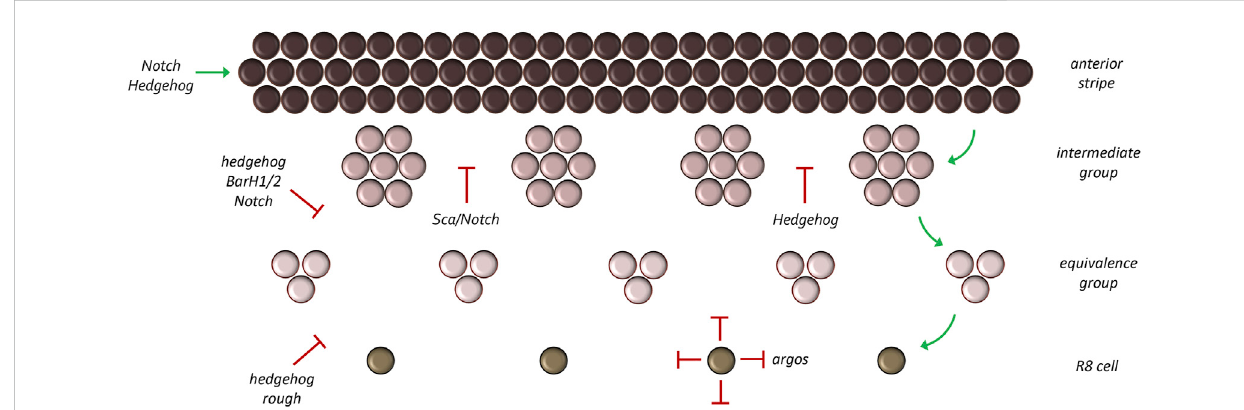
FIGURE 12 Re fi nement of the atonal expression pattern. Atonal is fi rst activated in a broad stripe ahead and within the morphogenetic furrow. As development proceeds, this broad pattern is reduced to acolumn of single cells through a series of re fi nement steps. During the fi rst step groups of 10 – 15 cells (called intermediate groups) retain atonal expression. In the second step, atonal expression within the intermediate groups will be eliminated from all but two to three cells — These are now called equivalence groups. In the last step, a single cell within the equivalence group will retain atonal expression. This cell, the R8 photoreceptor, is the founding cell of the